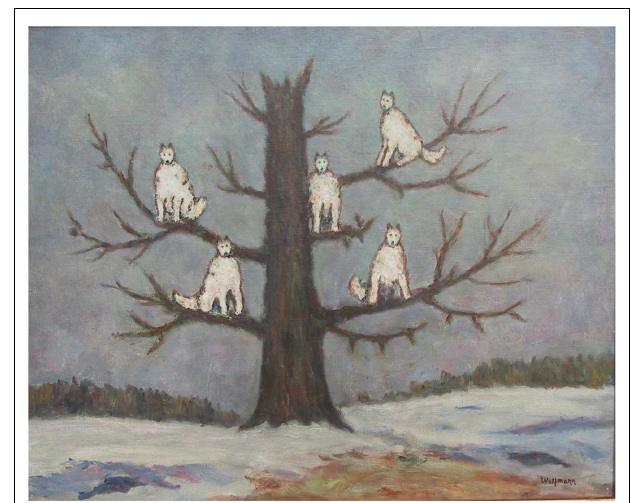
FIGURE 1 | Painting by the “wolfman” (Segei Pankejeff 1886–1979), from Freud (1918,